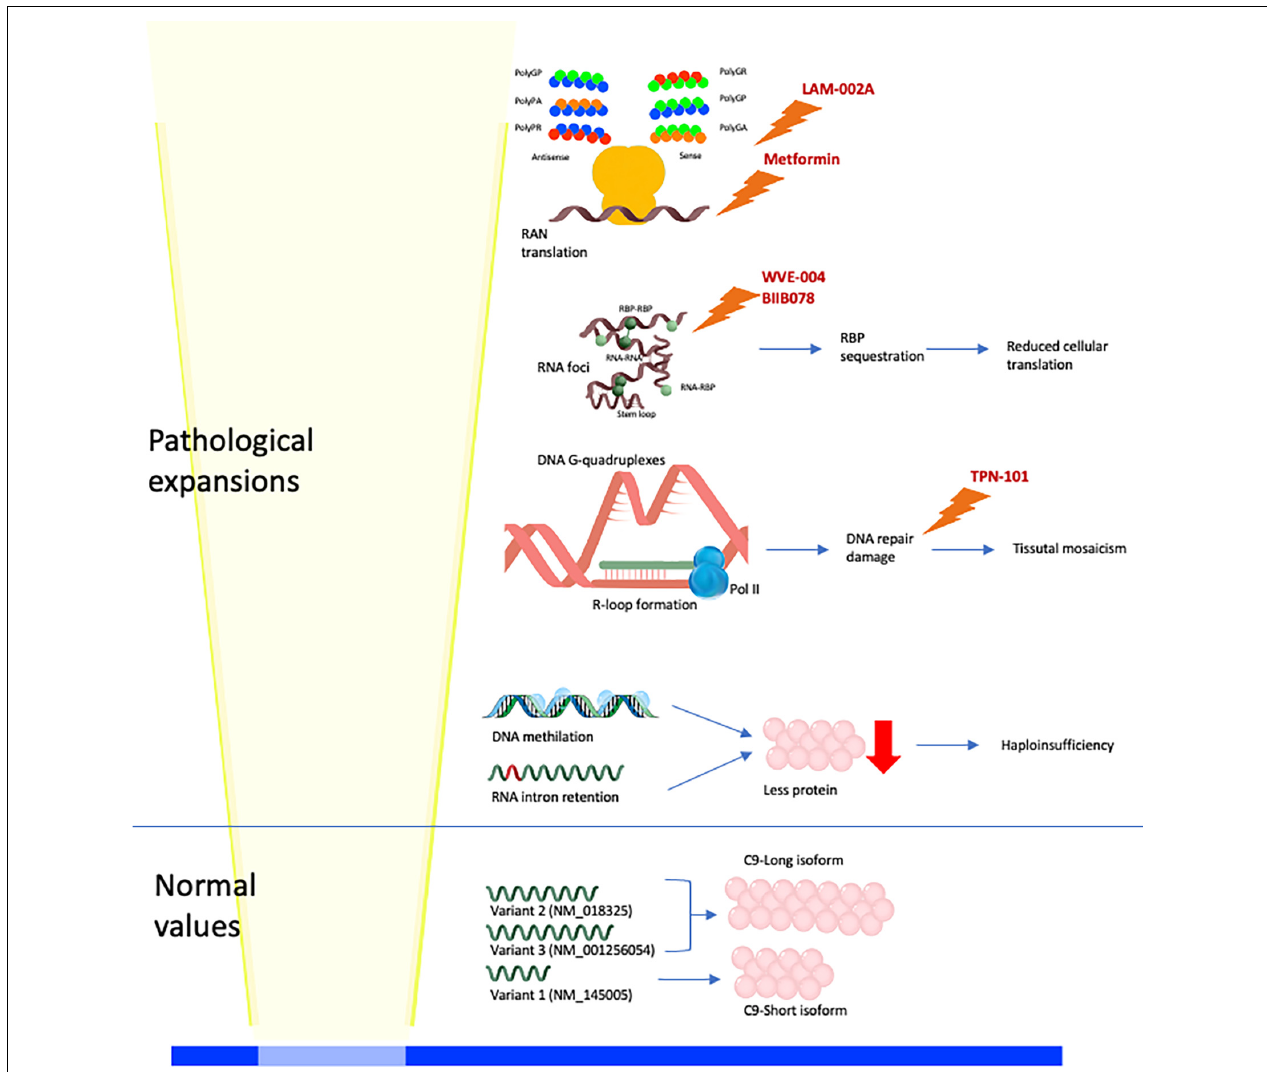
FIGURE 1 | Physiological and pathological molecular mechanisms linked to C9orf72 expansion. Normal alleles lead to the production of three mRNA (V1, V2, and V3), translated into two C9 isoforms (long and short; Smeyers et al., 2021). High-repeat expansion (HRE) C9orf72 alleles lead to four different pathological mechanisms: (i) hypermethylation of DNA and intron retention in mRNA leading to haploinsufficiency; (ii) DNA G-quadruplexes and R-loop formation leading to activation of DNA repair damage response and somaticmosaicism; (iii) RNA foci formation, with intramolecular (stem-loop, and G-quadruplexes) and intermolecular (RNA-RNA, RNA-RNA-binding protein (RBP), and RBP-RBP) interactions (Malik et al., 2021), leading to RBP sequestration and reduced cellular translation; (iv) RAN translation of sense and antisense mRNAs produces five different DPRs (polyGA, polyGR, polyGP, polyPR, and polyPA). Drugs of which it is known or supposed molecular function are reported: metformin reduces RAN translation, LAM-002A interferes with DPRs formation, WVE-004 and BIIB078 promotes the degradation of C9orf72 expanded mRNAs, TPN-101 reduces the DNA repair damage